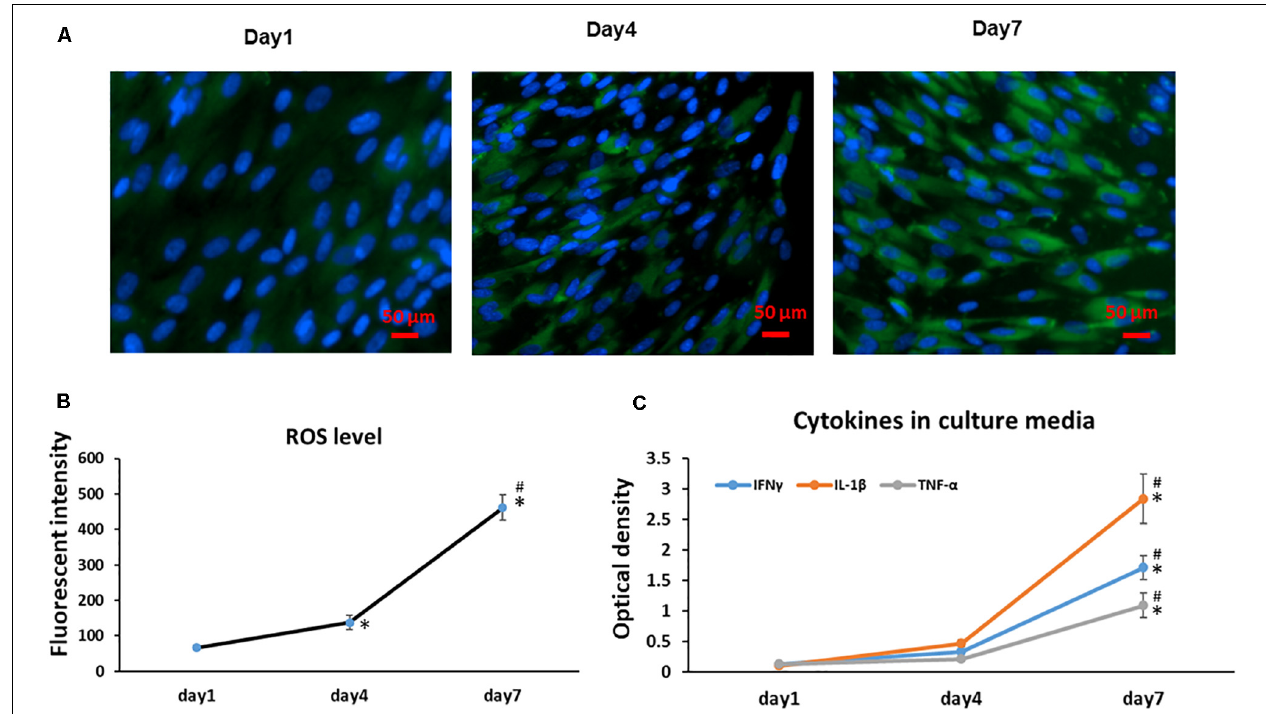
FIGURE 3 | Cell sheet culture increases ROS production in BMSCs. (A) Representative immunofluorescence imagines of ROS formation (green fluorescent), and Hoechst 33342 (blue) was used to detect the nucleus in BMSCs at the indicated Days (scale bars: 50 µ m). (B) Quantification of ROS level was achieved by calculation of the OD on randomly chosen areas (green positive), observing images at 200 × magnification by Image J. * P < 0.05 vs. Day 1 cells and # P < 0.05 vs. Day 4 cells. (C) Cytokines IFN γ , IL-1 β , and TNF- α increased rapidly in BMSC sheet culture medium from Day 1 to 7. * P < 0.05 vs. Day 1 cells. All experiments were performed in